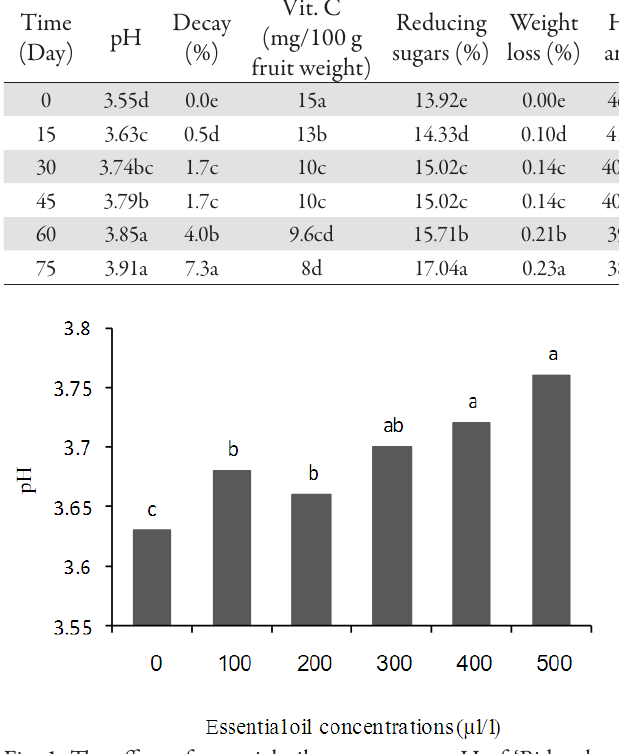
Fig. 2. The effect of essential oil treatment on decay percentage of ‘Bidaneh Qermez’ table